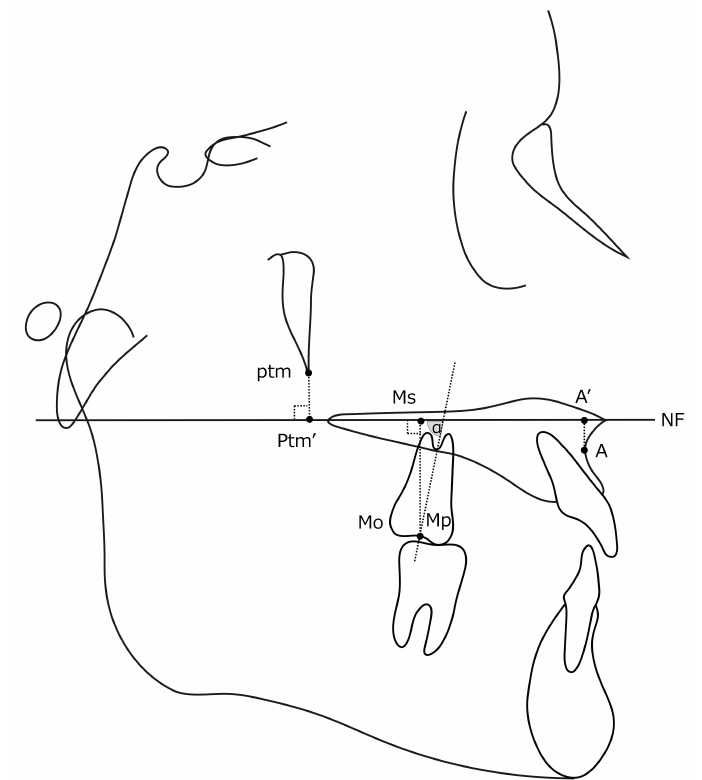
Figure 4. Measurement points and lines used for determining the mesiodistal position and axial incli- nation angles of the maxillary first molars. A (cid:48) , intersection of the palatal plane and the perpendicular line from point A; ptm (cid:48) , intersection of the palatal plane and the perpendicular line from ptm; Mo, midpoint of the occlusal surface of the maxillary first molars; Ms, intersection of the palatal plane and the perpendicular line from the midpoint of the occlusal surface of the maxillary first molars; Mp, line connecting the midpoint of the occlusal surface of the maxillary first molars and the midpoint of the mesial and distal root apexes; NF, palatal